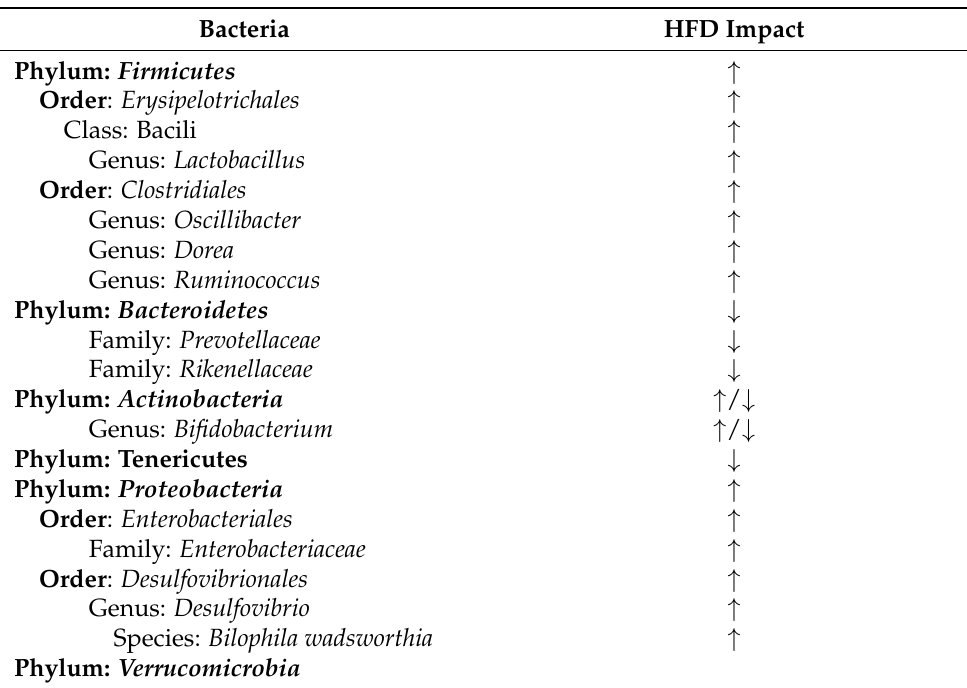
Table 2. The impact of a high-fat diet (HFD) on gut microbiota. Bacteria HFD